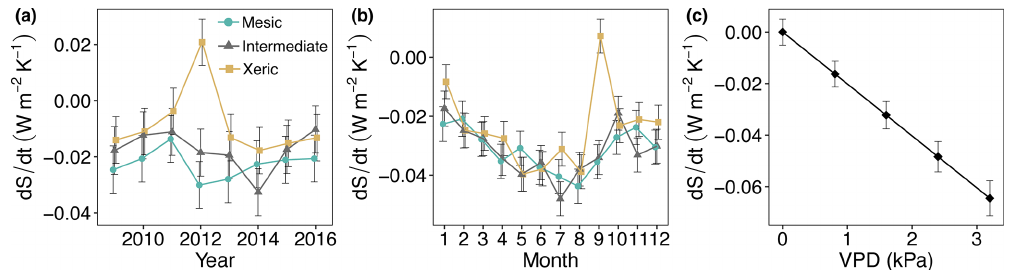
Figure 10. Least squares mean predicted values from mixed models of average daily entropy at the mesic, intermediate and xeric sites by (a) year, (b) month and (c) vapor pressure deficit (VPD). Soil water content and rain, as well as the interactions with site, were not significant in the model. Error bars represent